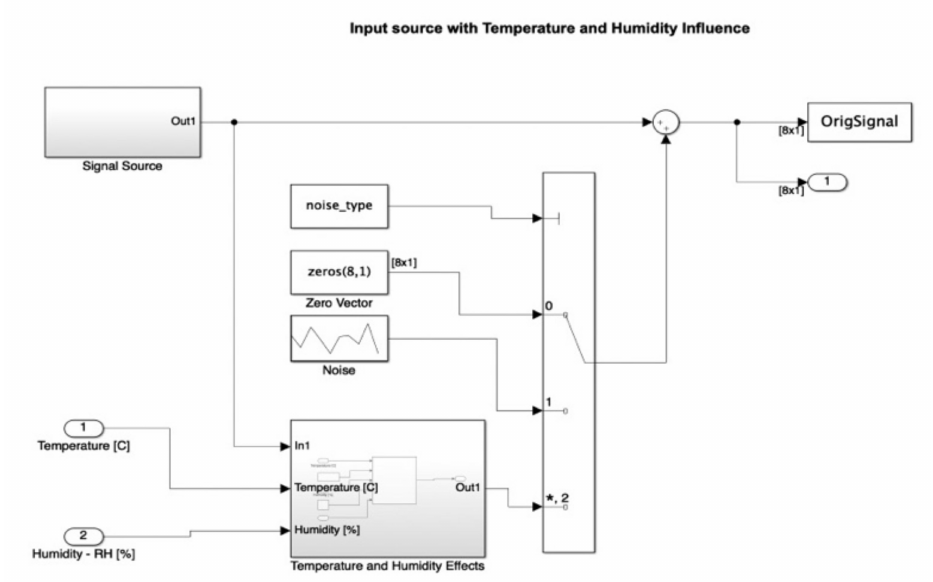
Figure 10. Detail of the modified input source diagram showing the temperature and humidity effects blocks added in the multiplication stage as noise. (*: value at the address of variable).